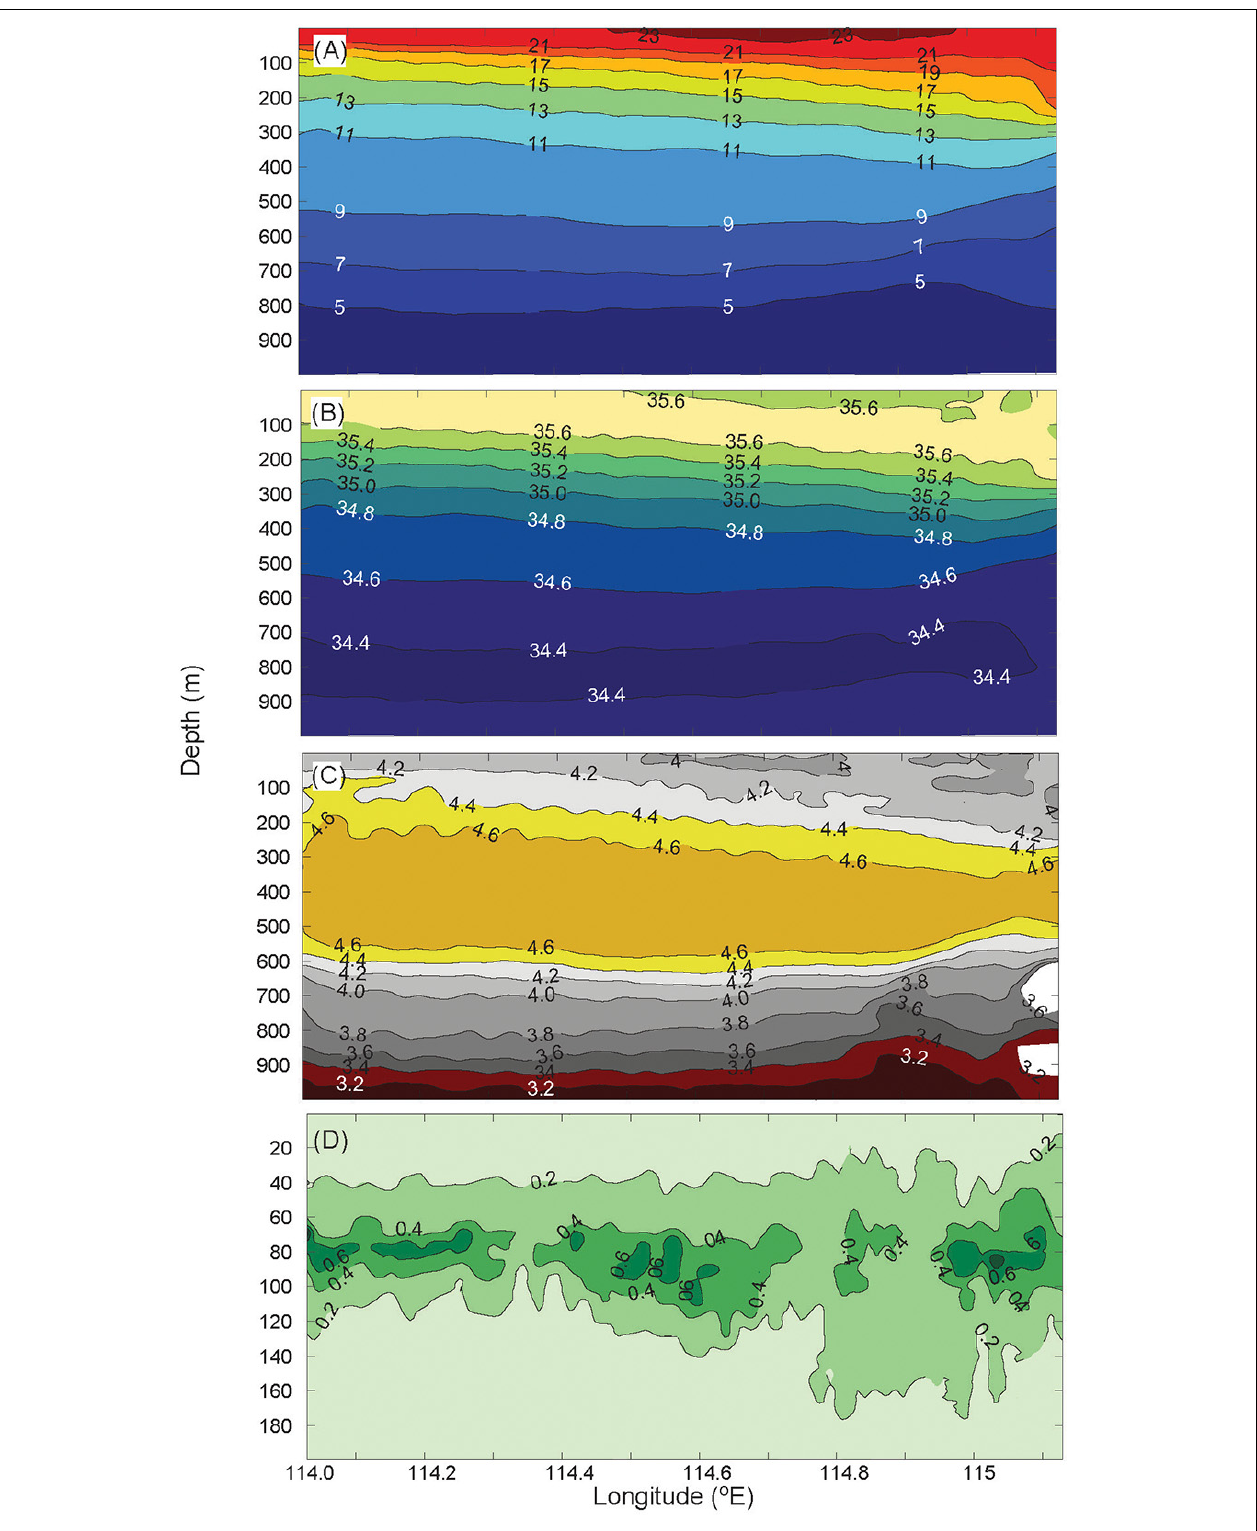
FIGURE 8 | Ocean glider transect across the canyon showing: (A) temperature, (B) salinity, (C) dissolved oxygen, and (D) chlorophyll fluorescence. Note that the chlorophyll fluorescence is shown for the upper 200 m.